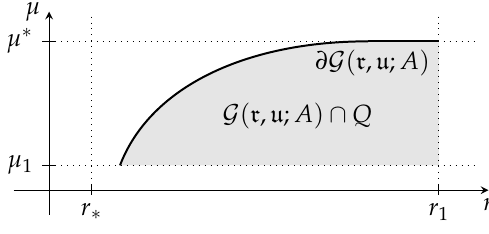
Figure 1. Illustration to show G eff ( r , u ; A ) (cid:54) = ∅